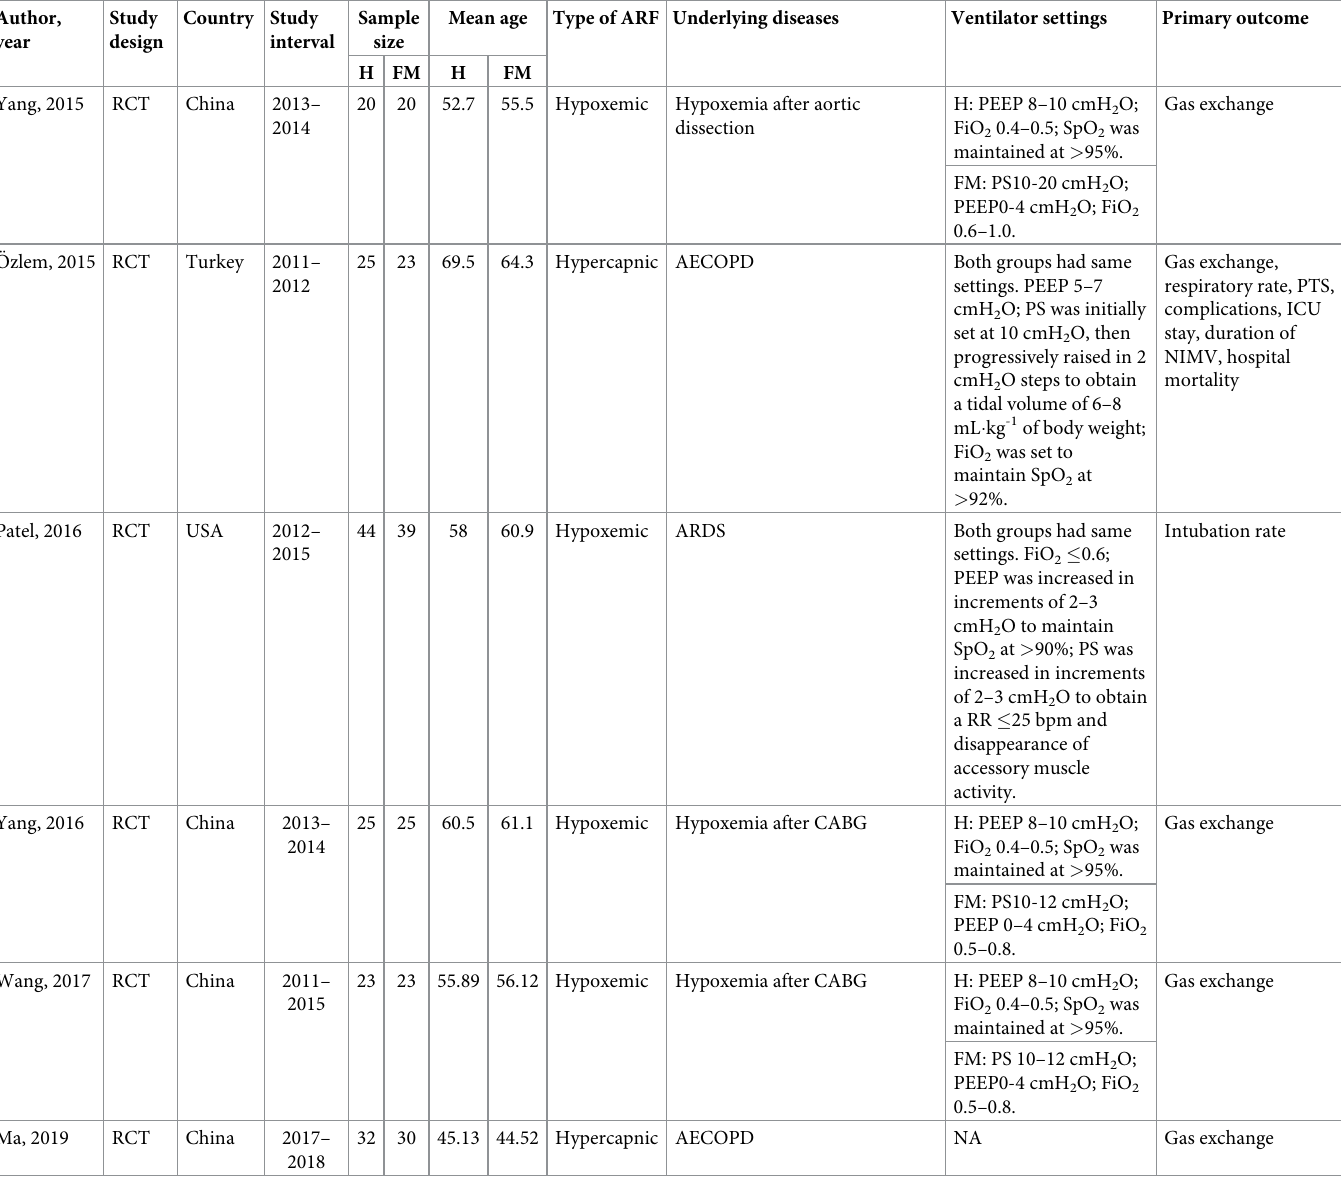
different between the two groups (MD 0.09 years; 95% CI − 1.16 to 1.33; p > 0.05; I 2 = 0%). Of 12 included RCTs, seven trials [11, 12, 36–38, 42, 43] enrolled patients with hypercapnic ARF, the others [9, 10, 39–41] employed patients with hypoxemic ARF. As shown in Table 1, venti- lator settings were not consistent across the